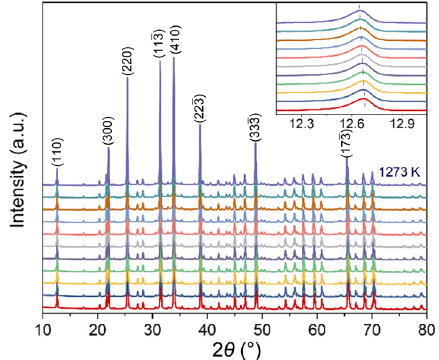
Fig. 7 XRD patterns of Zn 2 SiO 4 . The patterns were collected at room temperature and high temperatures in the range of 373  1273 K with an interval of 100 K. The inset shows the temperature dependence of (110) reflection.